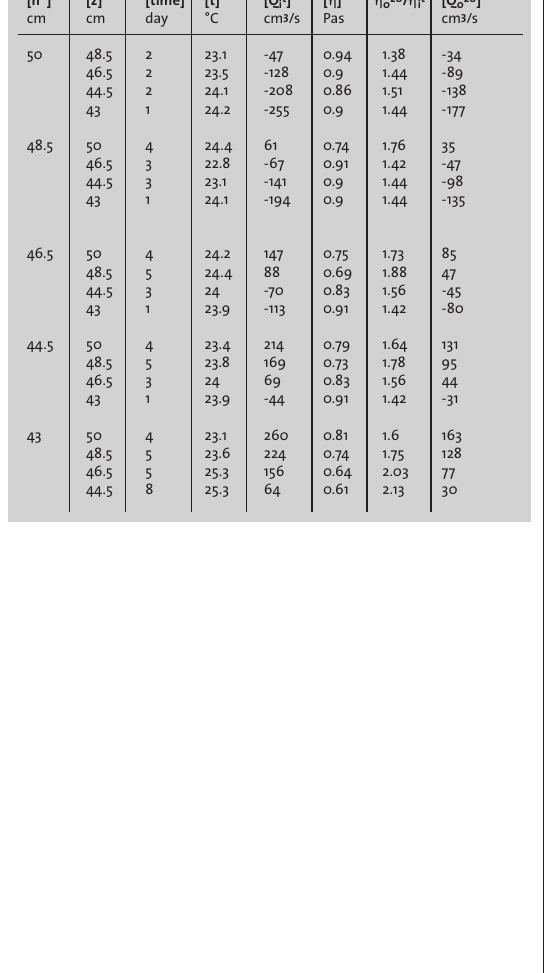
Table 1: Experimental data for measured discharges, Q it , and reduced discharges, Q 020 (b m /2 = 25